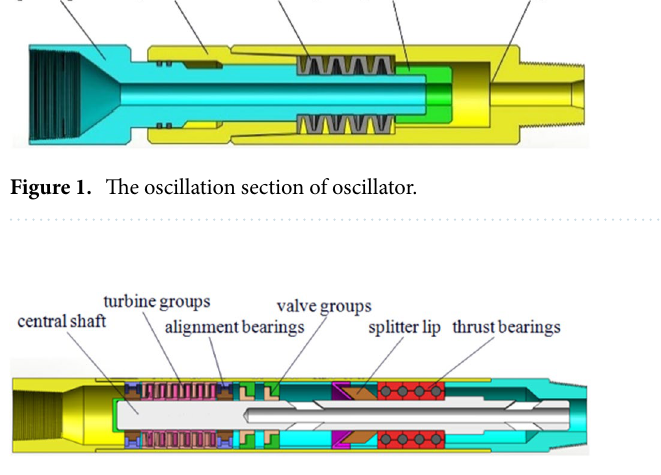
Figure 2. The drive section of oscillator.